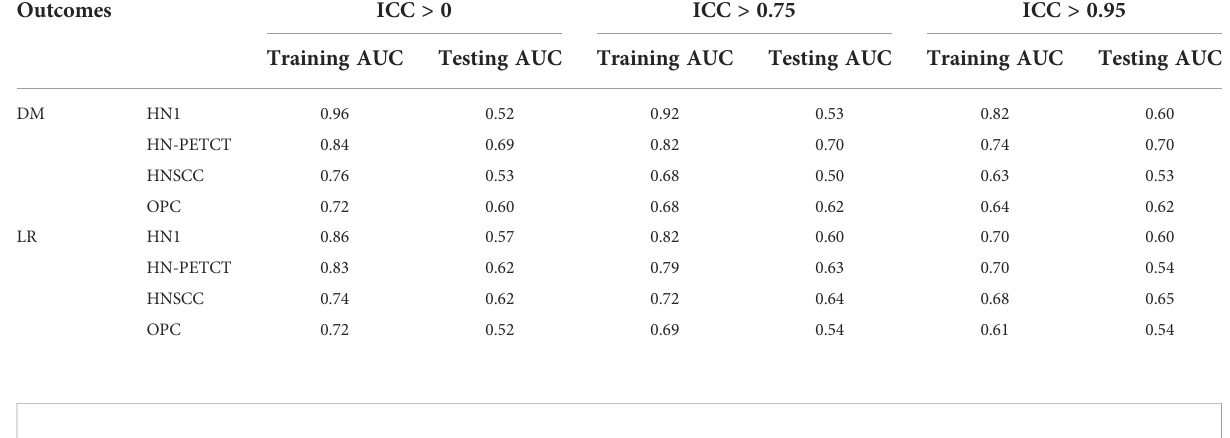
TABLE 4 The training and testing AUC between different feature robustness pre-screening thresholds.